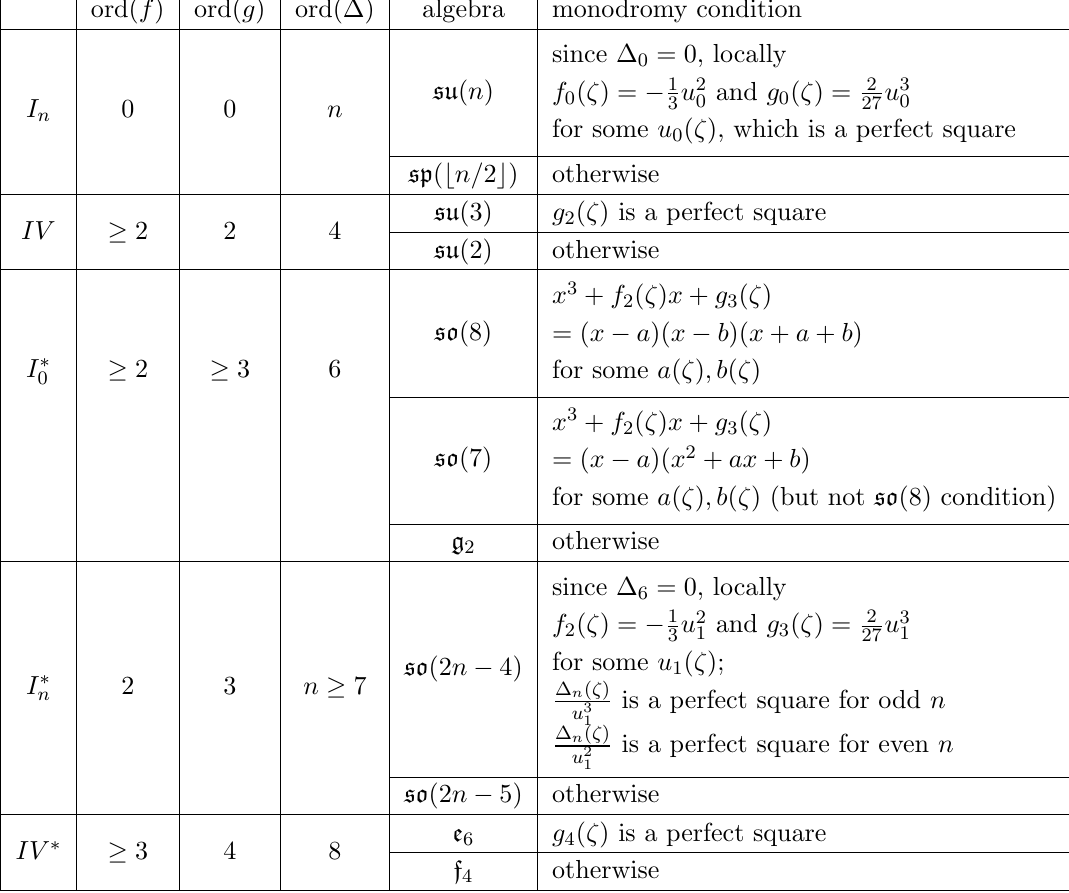
Table 3. Monodromy conditions for certain algebras to satisfy in additional to the desired orders